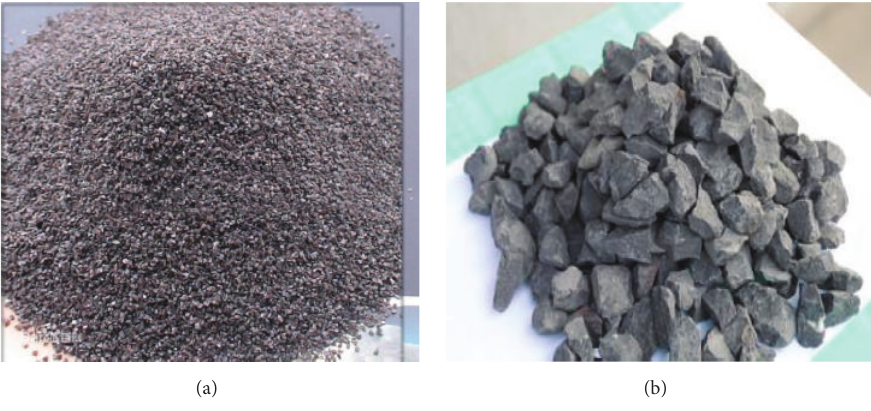
Figure 6: (a) Fine aggregates and (b) coarse aggregates.